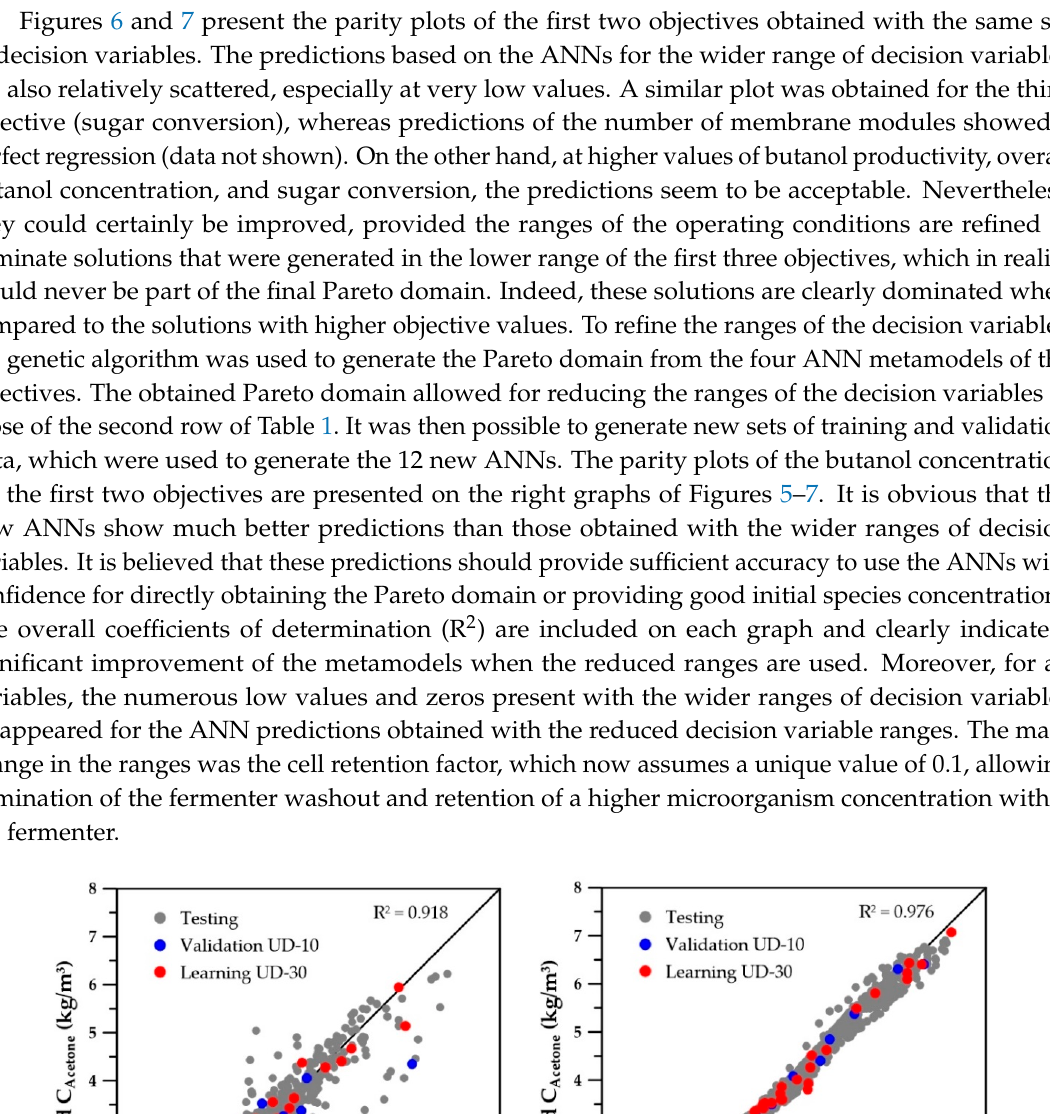
Table 1. Initial and reduced ranges of the decision variables.